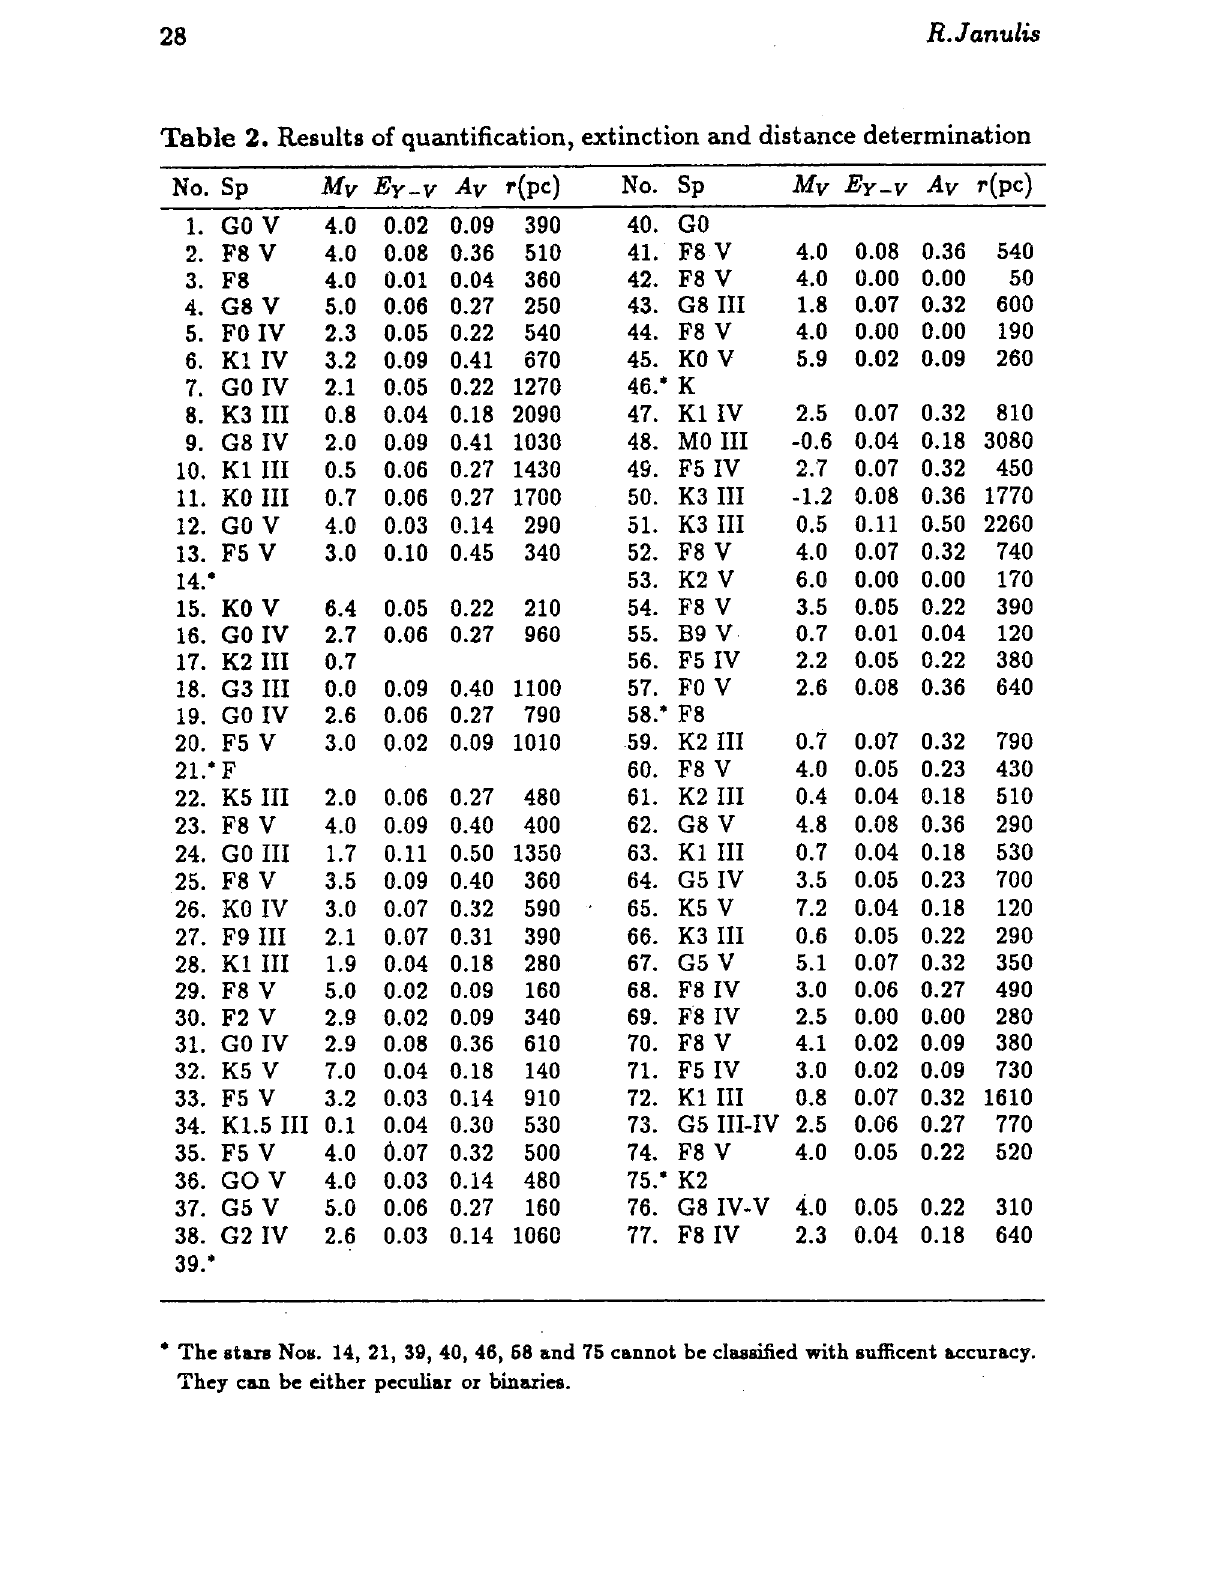
Table 2. Results of quantification, extinction and distance determination No.